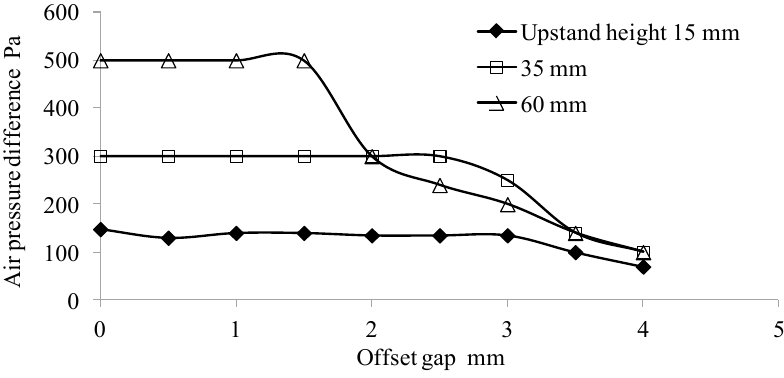
Figure 5. Air pressures at which water leakage occurrs through the H jointer as a function of upstand height and the offset gap